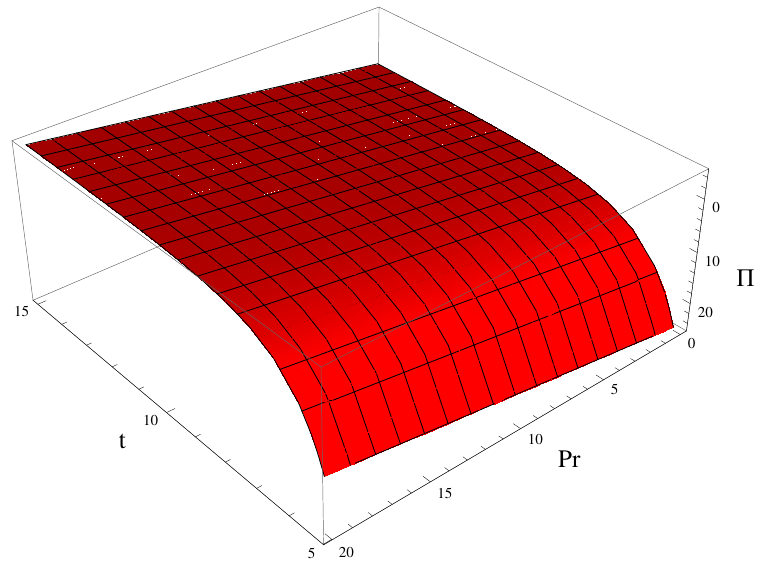
Figure 3. Anisotropic factor ( Π ) of self-gravitating compact objects via schematic diagrams for a suitable value of model parameter α , such as α = 0.66. One can examine through this diagram that, as the value of t increases, the system enters into an anisotropic